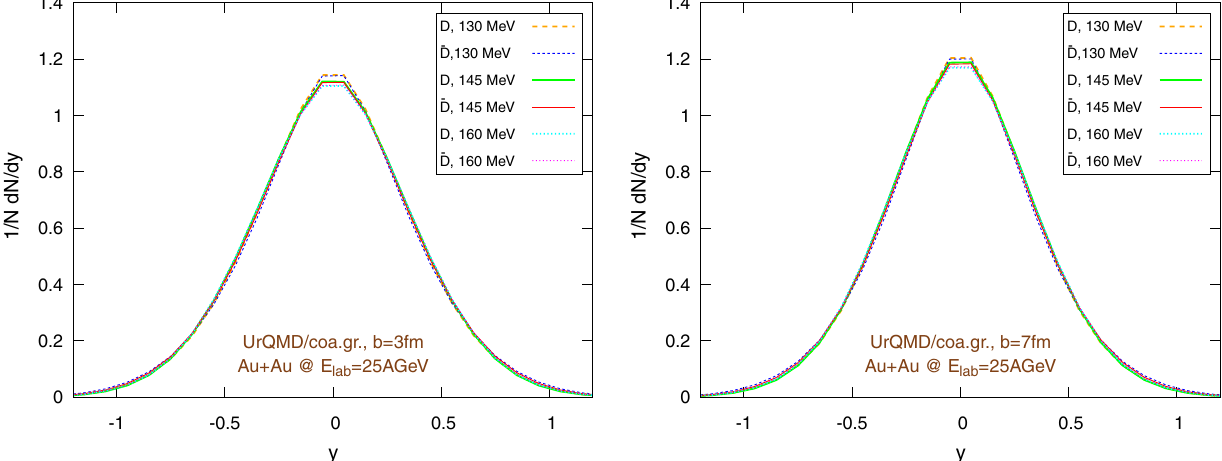
(cid:14) (cid:13) = 0 . 6fm. Left: b = 3fm, right: b = r D rms